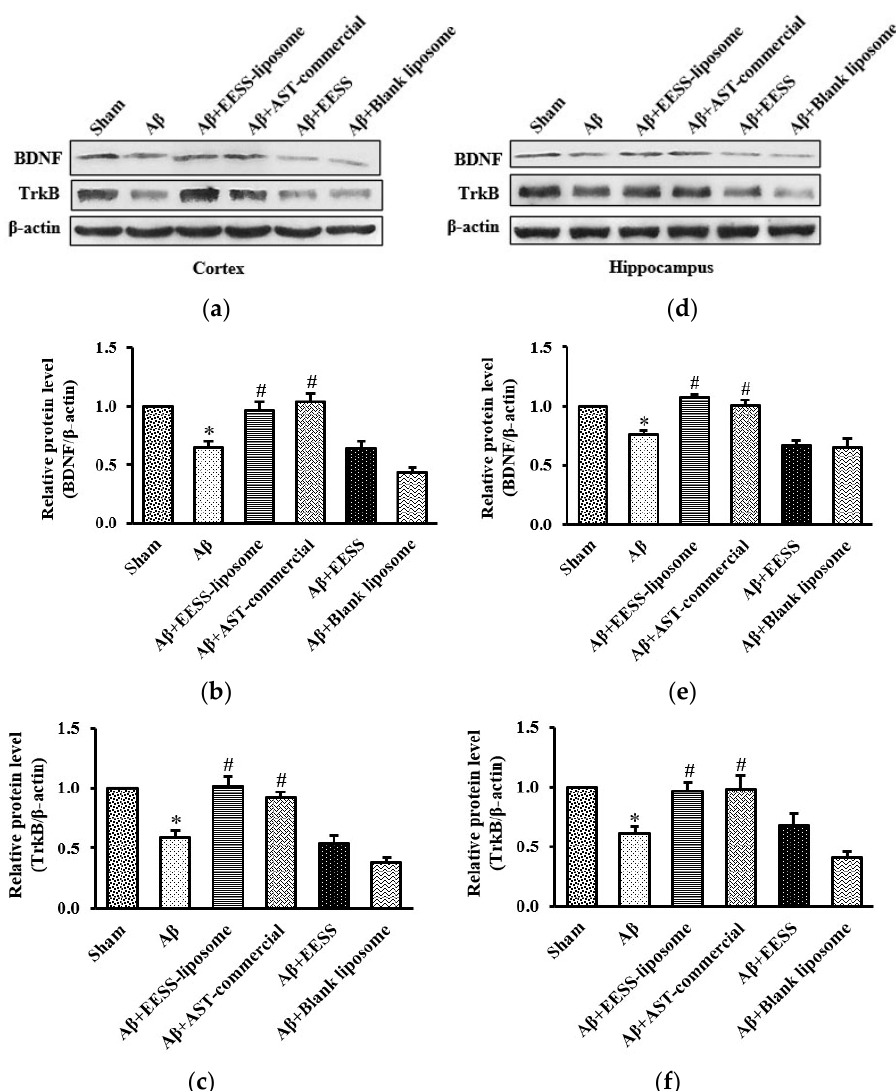
Figure 8. EESS-loaded liposome increased the levels of BDNF and TrkB in AD rats. ( a , d ) show representative images of Western blot analysis of BDNF and TrkB in the cortex and hippocampus, respectively. ( b , e ) show the relative BDNF levels in the cortex and hippocampus, respectively. ( c , f ) show the relative TrkB levels in the cortex and hippocampus, respectively. Data were presented as means ± SEM. * indicates significant difference ( p < 0.05) between A β and sham groups; # indicates significant difference ( p < 0.05) between EESS-loaded liposome, AST-commercial and A β groups; n = 5 rats/group.